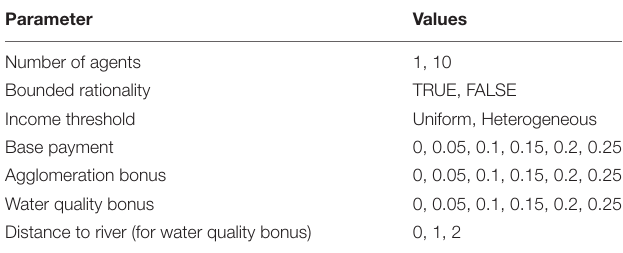
TABLE 1 | Parameter values used in the